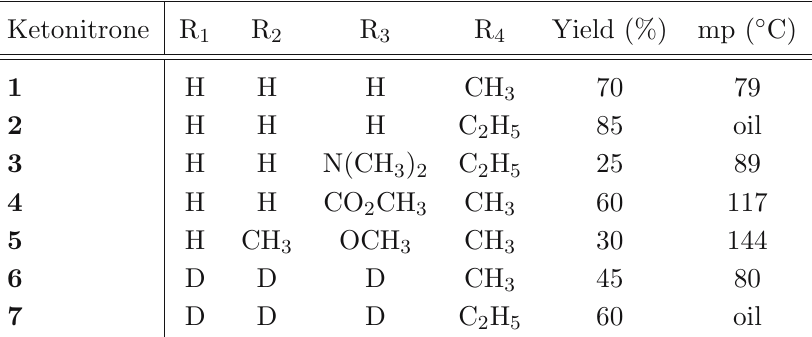
Table 1 Synthesis yields of ketonitrones 1 - 7